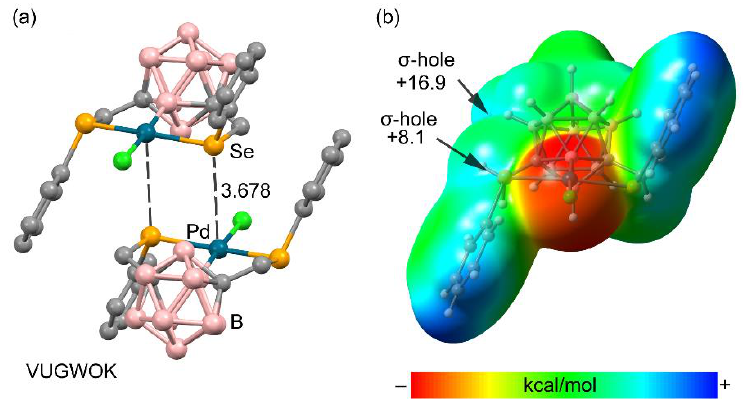
Figure 9. ( a ) Partial view of refcode VUGWOK structure. Distance in Å . H-atoms omitted for clarity. ( b ) MEP surface (isodensity 0.001 a.u.) of VUGWOK. The energies at the σ -holes are indicated in kcal/mol.